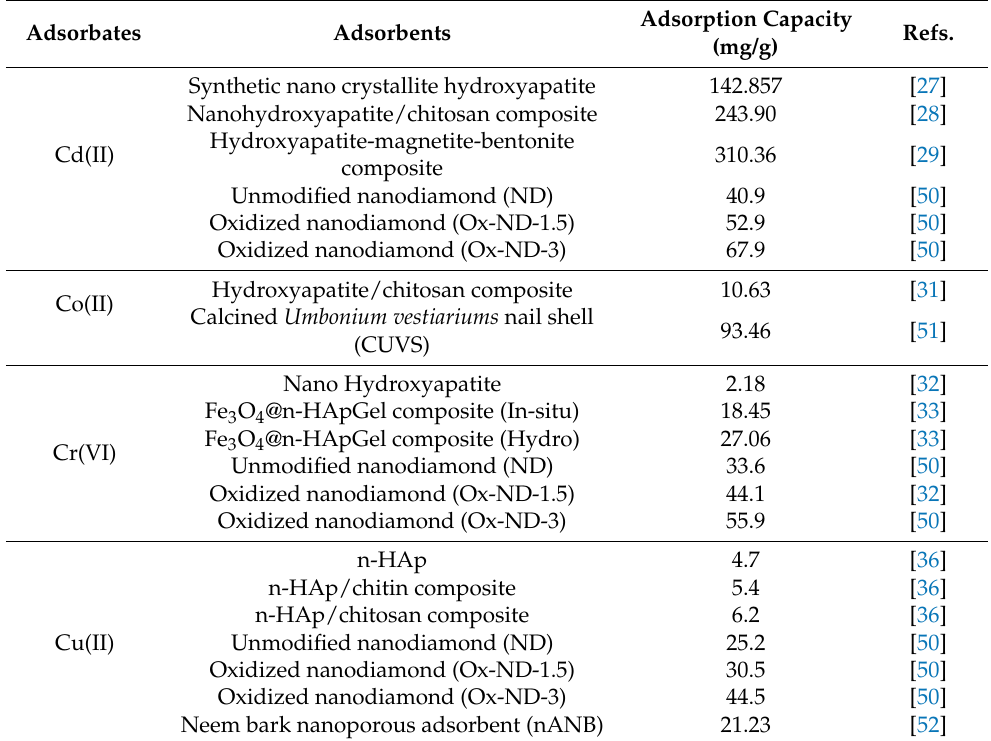
Table 1. Comparison of the adsorption capacities of nano HAp and its composites with other absorbents on heavy metal